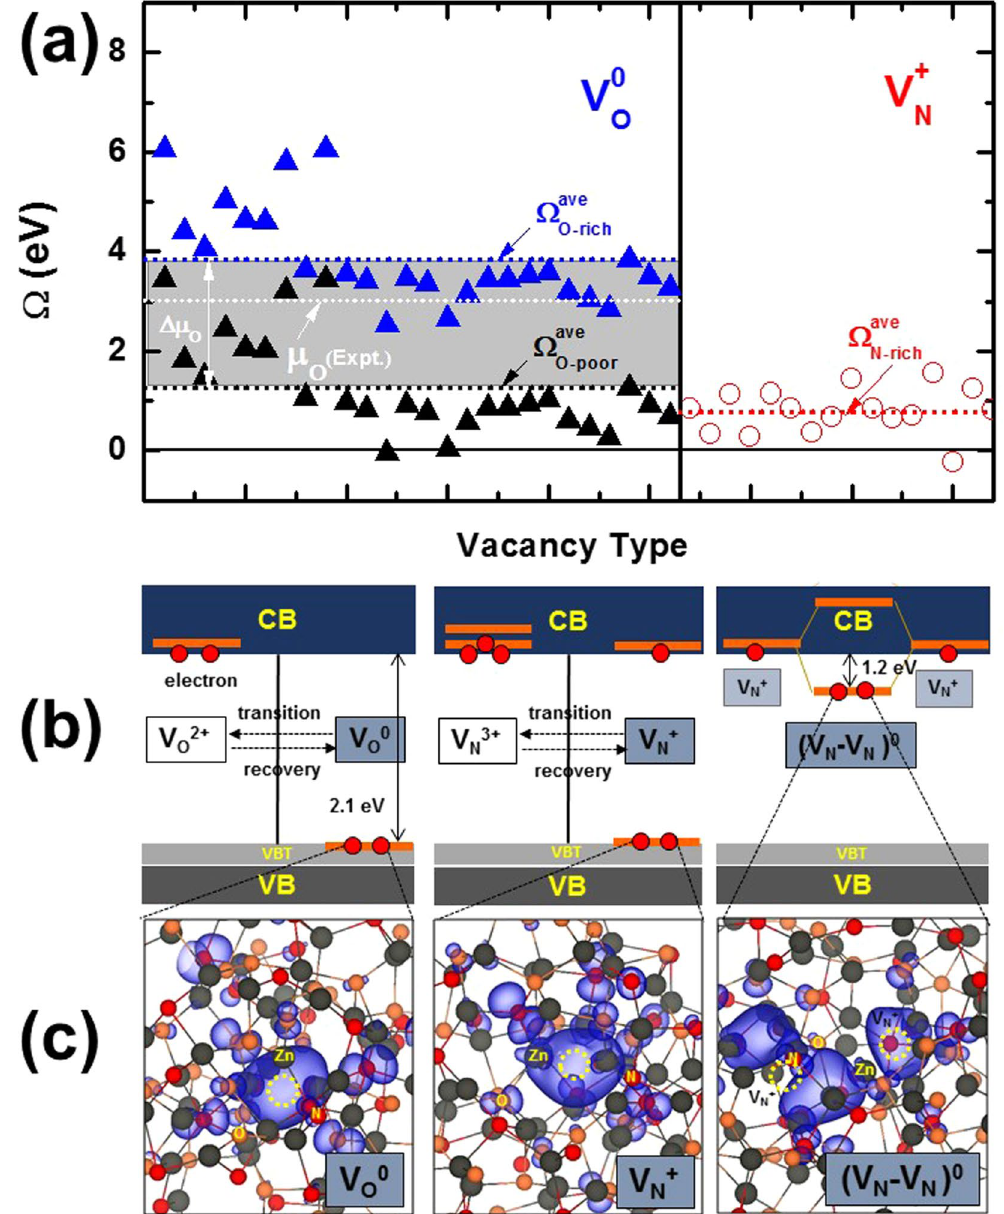
Figure 1. ( a ) When the Fermi level is located at the conduction band minimum (CBM), the formation enthalpy values of both shallow V N + (red open circles) and deep V O0 defects (blue and black solid triangles for O-rich and O-poor conditions, respectively) are shown for all anion vacancies in the selected amorphous ZnON (as an example, with an O/N ratio of 1.625). Red, blue, and black short-dotted lines indicate the average formation richave , Ω richave , and Ω poorave ), respectively. To enthalpy values of N-rich V N + , O-rich V O0 , and O-poor V O0 ( Ω − − O − O N compare the formation enthalpy values of the V N + defects with those of the V O0 defects under experimental growth conditions of amorphous ZnON, the experimental oxygen chemical potential, μ O ( Expt .) = μ O ( T , p ), was estimated at the growth temperature ( T = about 300 K) and gas pressure ( p = 5 mTorr) 24 . ( b ) The electronic defect levels of V N , V O , and nitrogen divacancy (V N -V N ) 0 are schematically depicted, respectively. VB, VBT, and CB stand for valence band, valence band tail, and conduction band, respectively. ( c ) Charge density plots of the highest occupied deep levels for V N + , V O0 , and (V N -V N ) 0 are shown, respectively, with an isosurface value of 1.25 × 10 − 5 Å − 3 (specific vacancy sites are assigned by yellow dotted